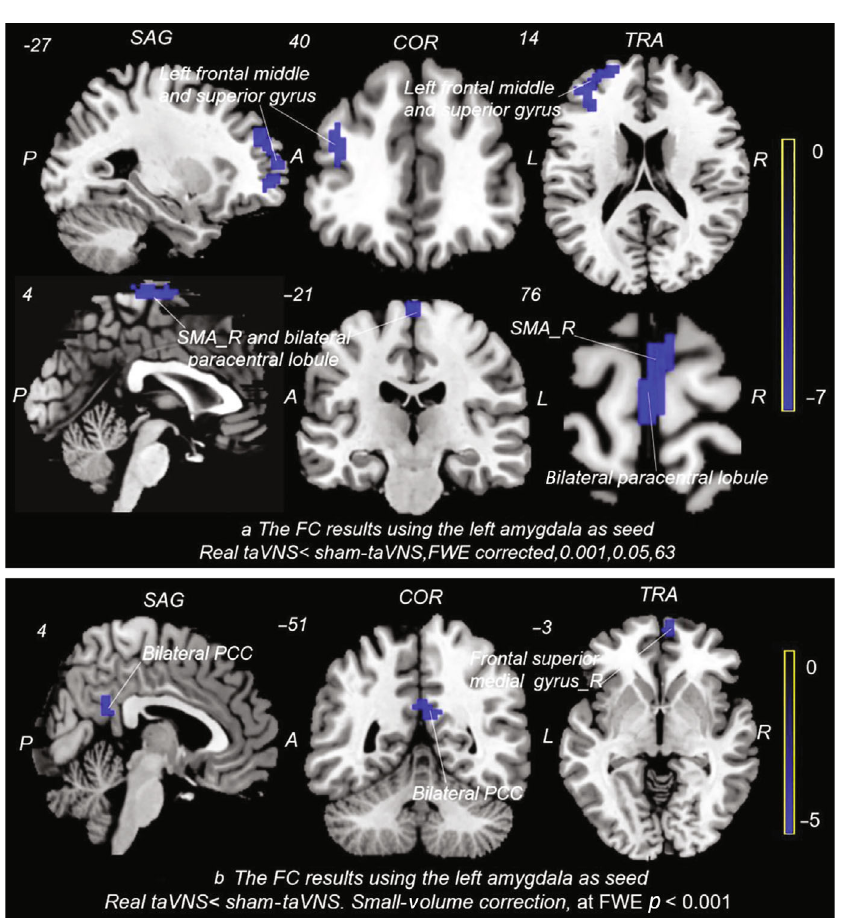
Figure 3: The functional connectivity (FC) of the left amygdala in MwoA during continuous stimulation (taVNS vs. staVNS). L: left; R: right; P: posterior; A: anterior; SAG: sagittal; COR: coronal; TRA: transverse; PCC: postcingulum gyrus; SMA: supplementary motor area; FWE: familywise error correction. Compared with sham-taVNS, the FC signi fi cantly decreased between the left amygdala and left frontal middle gyrus, left frontal superior gyrus, right SMA, bilateral paracentral lobule ((a) FWE multiple comparison correction, voxel-level p < 0 : 001 and cluster-level p < 0 : 05 ), bilateral PCC, and right frontal superior medial gyrus ((b) small-volume correction, FWE p < 0 : 001 ) in